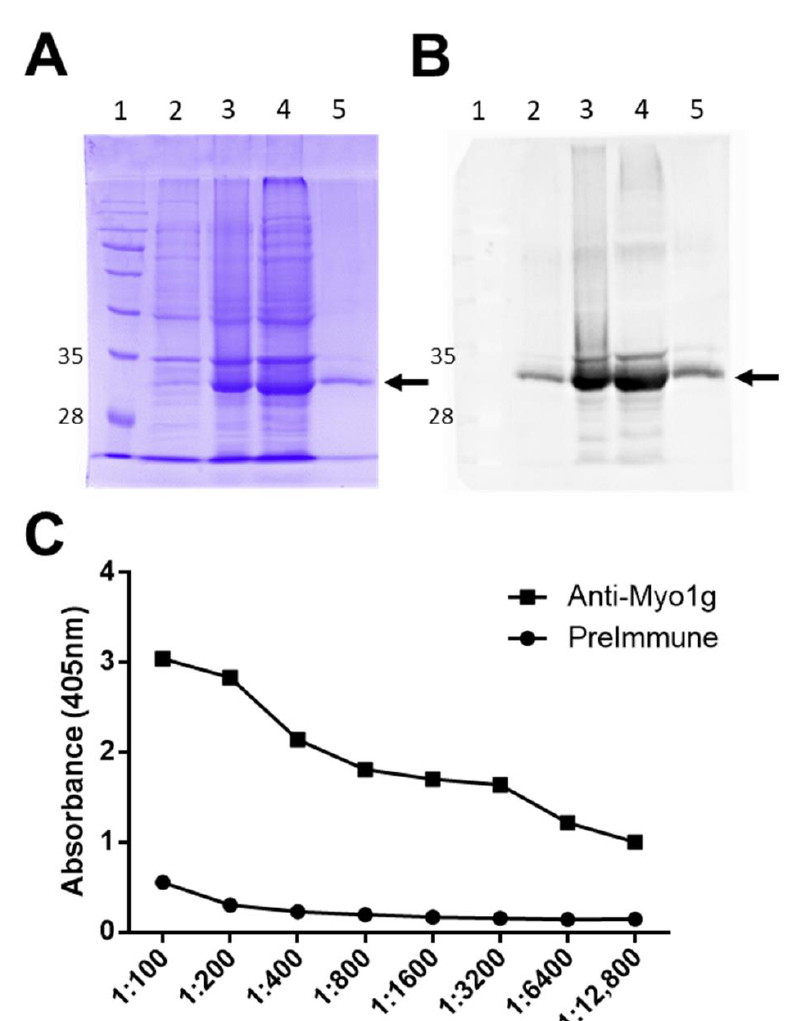
Figure 1. Production and purification of recombinant human Myo1g IQ-Tail and antibody induction in mice. ( A ) SDS-PAGE analysis of rhMyo1g IQ-Tail protein in lysates from control culture (2), induced culture (3), insoluble fraction (Pellet) (4), and purified protein (5) in a 12% gel stained with Coomassie brilliant blue R-250, MW Markers (1). ( B ) WB analysis of His-tagged proteins in an identical distribution as ( A ), the membrane was analyzed by chemiluminescence. Molecular weight of Myo1g IQ-Tail = 34 kDa is indicated by an arrow ( A , B ). ( C ) Antibody titers of one mouse after five immunizations with the rhMyo1g IQ-Tail protein.